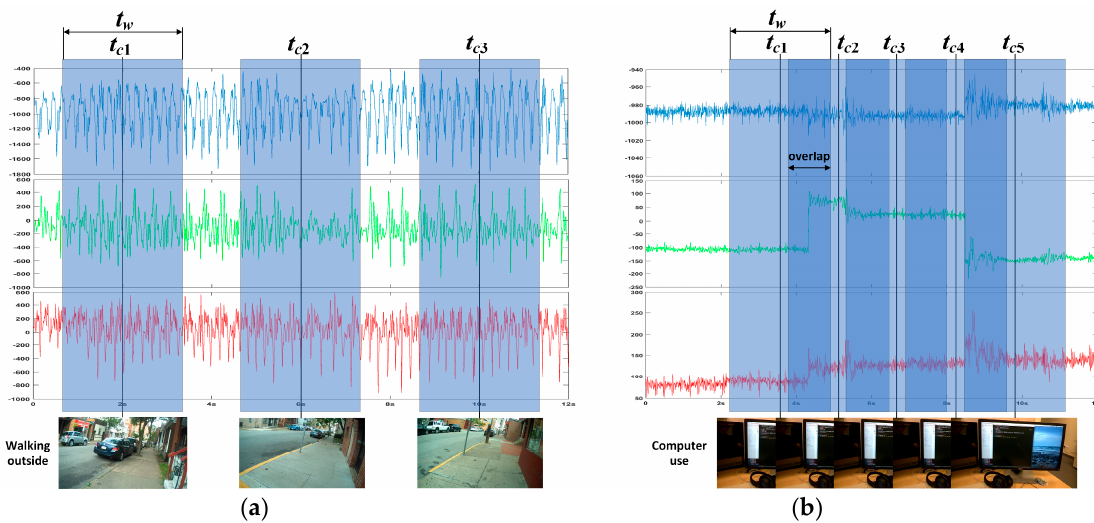
Figure 4. Schematic diagram of the correspondence between sensor data and images (or image sequences): ( a ) When the sampling rate of images is low, there is no overlap between the time windows. ( b ) When the sampling rate of the images is higher and the time window is wider, overlap occurs between the time windows.